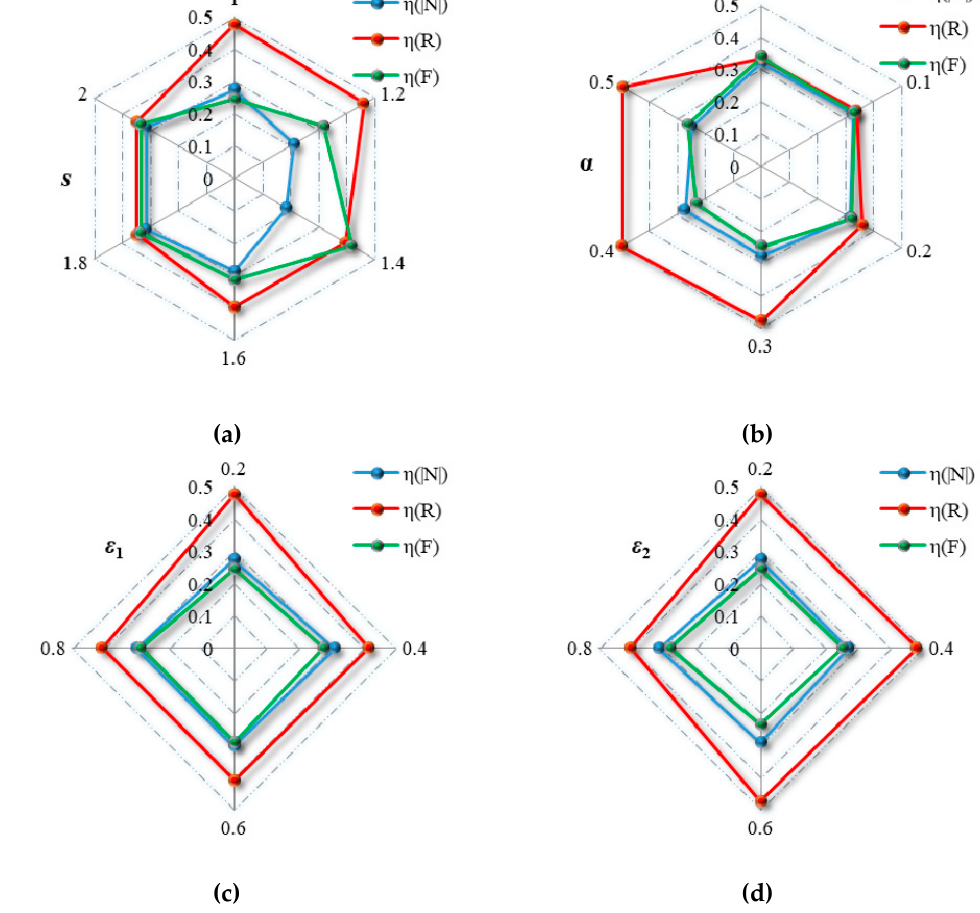
Figure 13. Contribution rate of η (| N |), η ( R ) and η ( F ) to V in different conditions. ( a ) α = 0.3, ε ( b ) s = 1.0, ε 1 = ε 2 = 0.2; ( c ) s = 1.0, α = 0.3, ε 2 = 0.2; ( d ) s = 1.0, α = 0.3, ε 1 = 0.2. Data is derived